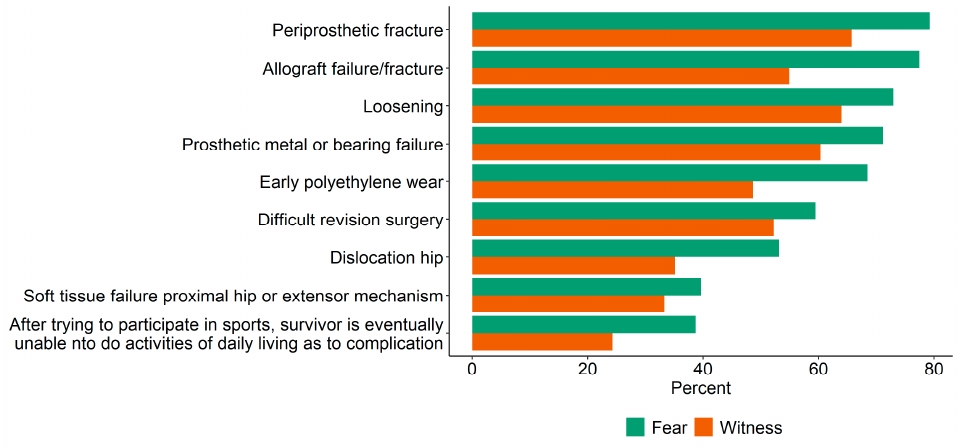
Figure 1. Percent of respondents who feared and witnessed post-surgery complications due to sports activity.